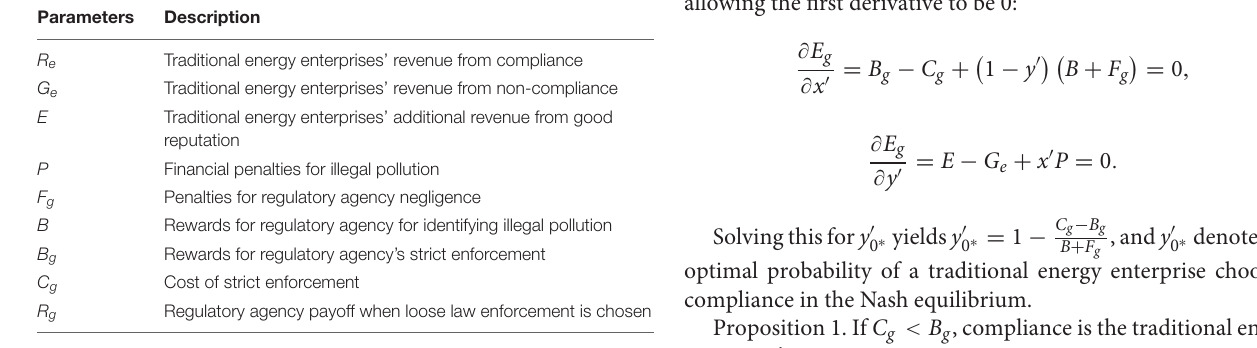
TABLE 2 | Payoff matrix of a regulatory agency and a traditional energy enterprise mixed-strategy game.